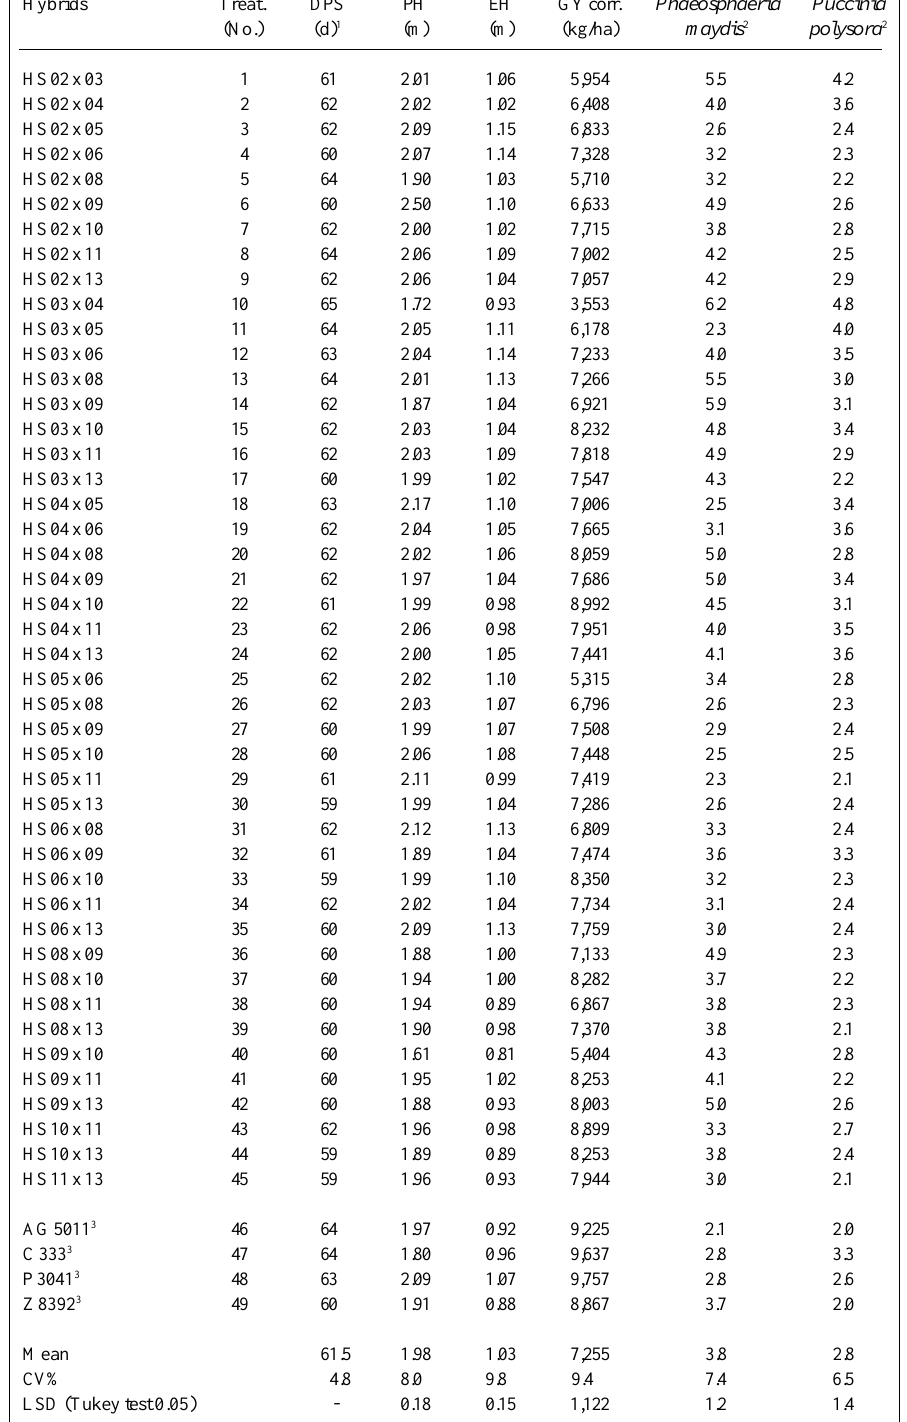
Table I - Means for days (d) to mid-tassel pollen shed (DPS), plant height (PH), ear height (EH), grain yield (GY corr.) in kg/ha corrected for 14% moisture and ideal stand, and disease severity scores for 45 single-cross maize hybrids of a 10 x 10 diallel evaluated at four locations in São Paulo State. Hybrids